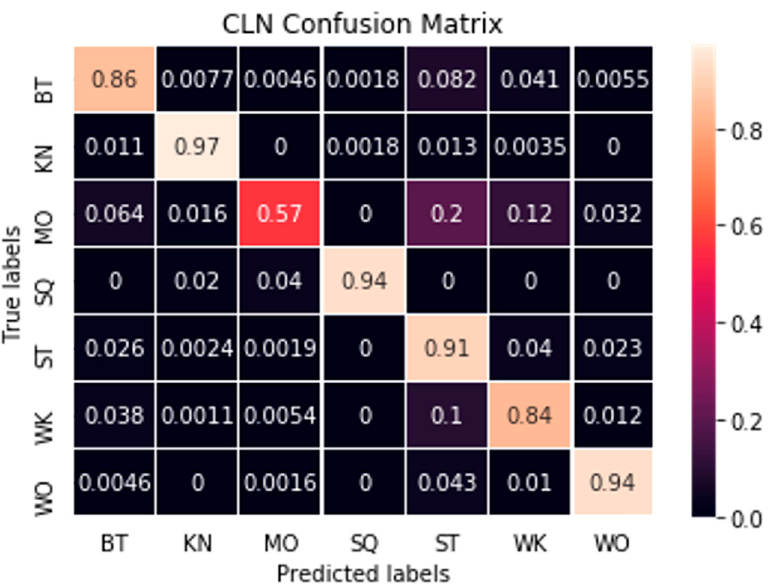
Figure 10. Confusion matrix of posture recognition. The numbers were normalized for better inter- pretation.